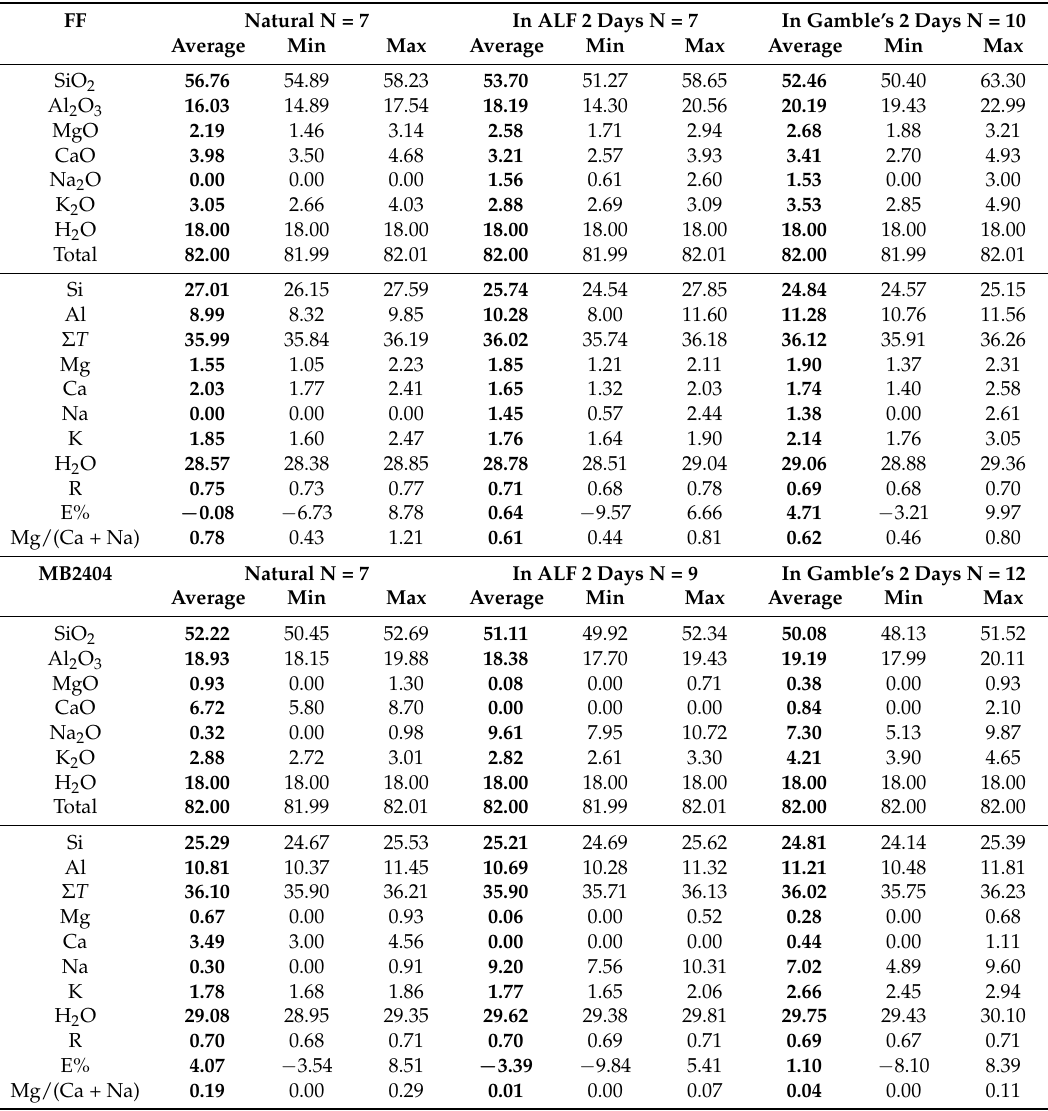
Table 3. Chemical composition of the investigated samples: average values (N is the number of point analyses), minimum and maximum values. Σ T is the sum of cations in tetrahedral sites; E%, measure of charge balance: E% = 100 × [Al − Alk th ]/Alk th where Alk th = Na + K + 2 × (Ca + Mg); R = Si/(Si + Al) ratio. Crystal chemical formula calculated on the basis of 36 (Si + Al) apfu. Assumed water content of 18 wt